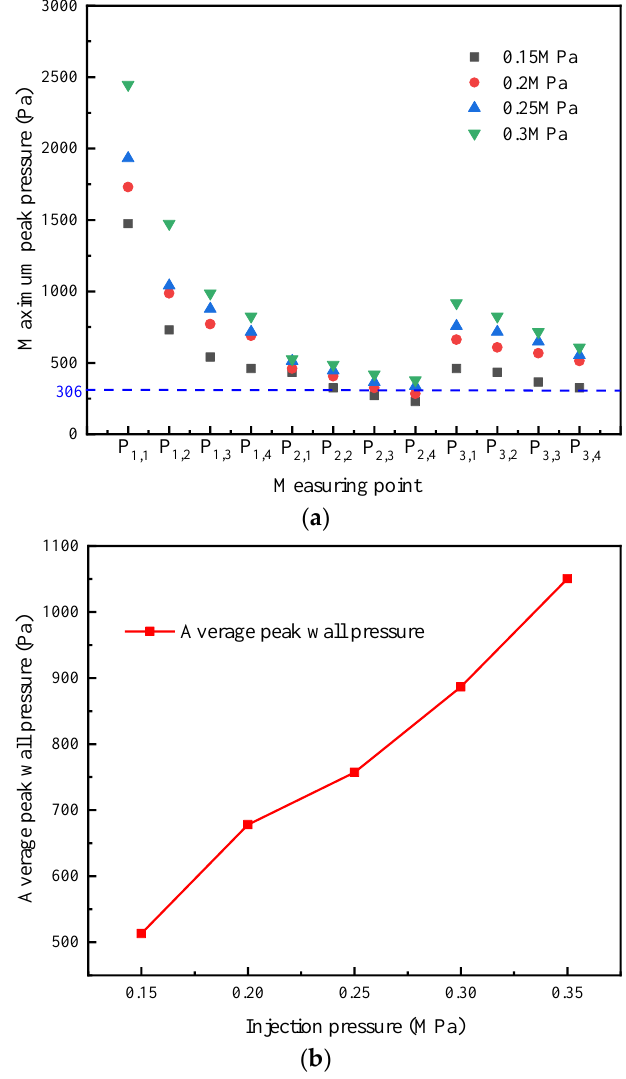
Figure 4. The effect of injection pressure on the wall surface peak pressure. ( a ) The maximum peak pressure of each measuring point under different injection pressures. ( b ) The average wall surface peak pressure (AWSPP) of the under different injection pressures.